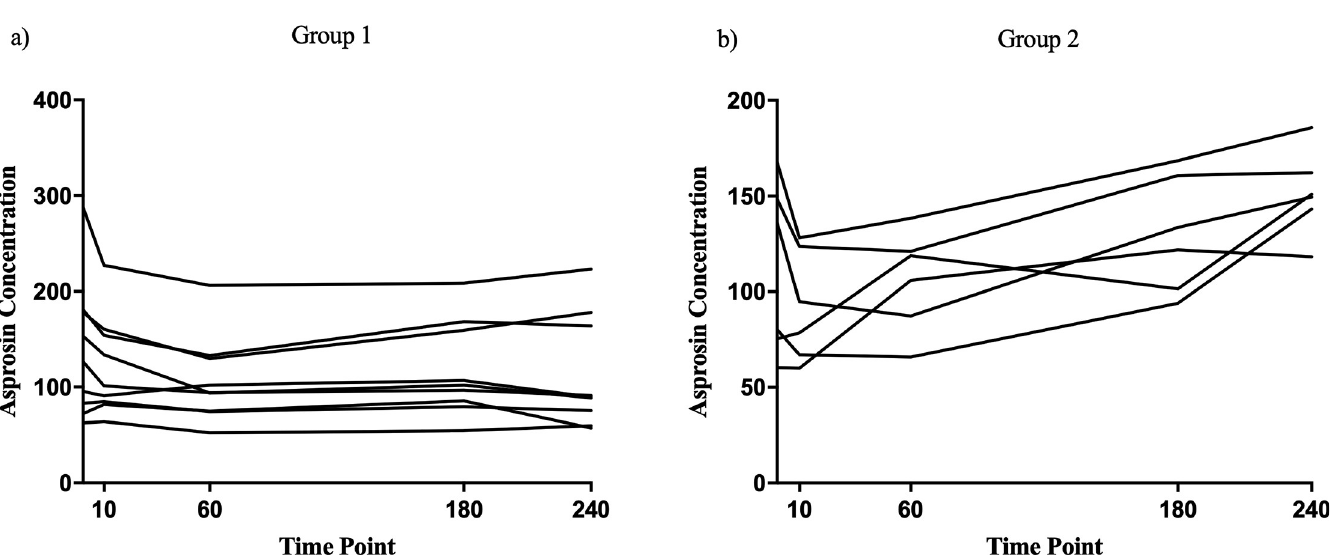
Fig 2. Individual asprosin concentrations. Individual asprosin concentrations during the ivGTT and clamp study. X-Axis shows the time points in minutes. 0 = baseline before the ivGTT was started, median blood glucose level was 159 mg/dl. 10 = ten minutes after intravenous glucose injection, median blood glucose level was 267 mg/dl. 60 = 60 minutes after intravenous glucose injection, median blood glucose level was 227 mg/dl. 180 = during the hyperinsulinemic clamp at a median glucose level of 89 mg/dl in a steady state. 240 = during the hyperinsulinemic clamp at a median glucose level of 58 mg/dl in a steady state. There was no statistical difference between the absolute values of asprosin levels at the different time points. However, the delta values between baseline asprosin levels and asprosin levels during hypoglycemia were significantly different between the groups (p < 0.001). Asprosin concentrations are given in nanograms per milliliter. (a) Individual asprosin concentrations of patients without increase in asprosin concentrations during initial blood glucose lowering or hypoglycaemia (group 1, n = 9). (b) Individual asprosin concentrations of patients with increase in asprosin concentrations during initial blood glucose lowering or hypoglycaemia (group 2, n = 6). ivGTT = intravenous glucose tolerance test. mg/dl = milligrams per deciliter.